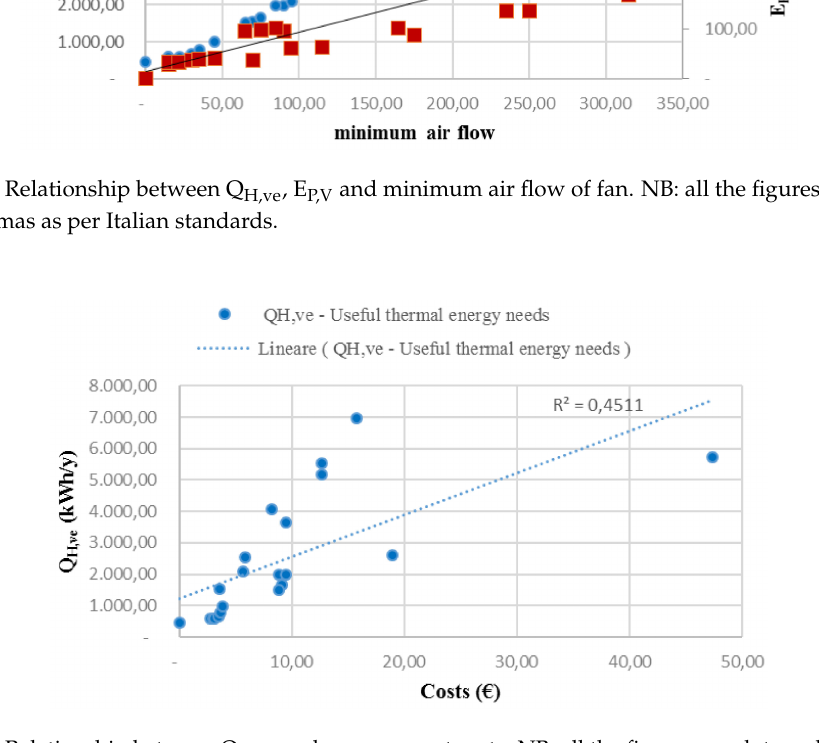
Figure 6. Relationship between Q H,ve and management costs. NB: all the figures use dots and commas as per Italian standards.